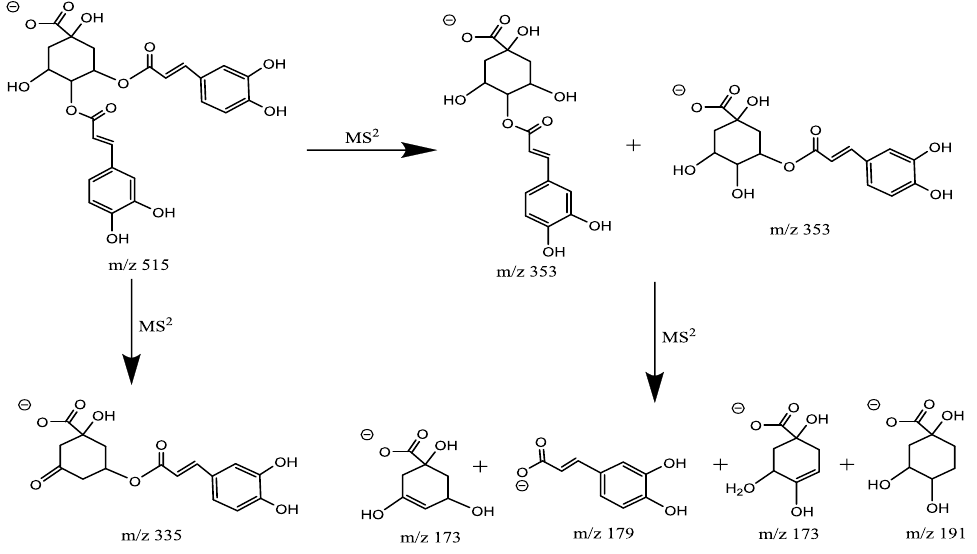
Figure 7. Fragmentation pathways of di-caffeoylquinic acid.